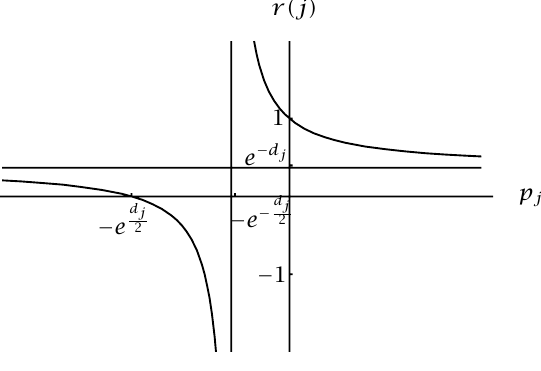
Figure 5.1 . Ratio function r(j) for b(t) = b cos ( 2 πt) , j = 1, a = 1 /π